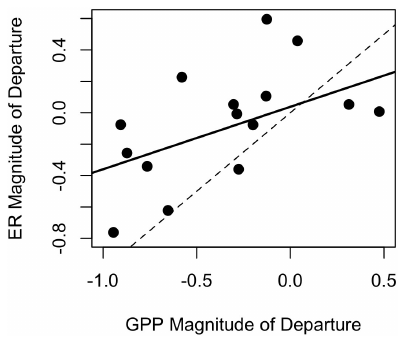
Figure 5. Resistance (i.e., magnitude of departure) of gross primary production (GPP) versus ecosystem respiration (ER) in Stroubles Creek, VA. Dashed line is the 1:1 line; solid line is the linear model fit through all data ( R 2 = 0 . 25, p = 0 . 03).